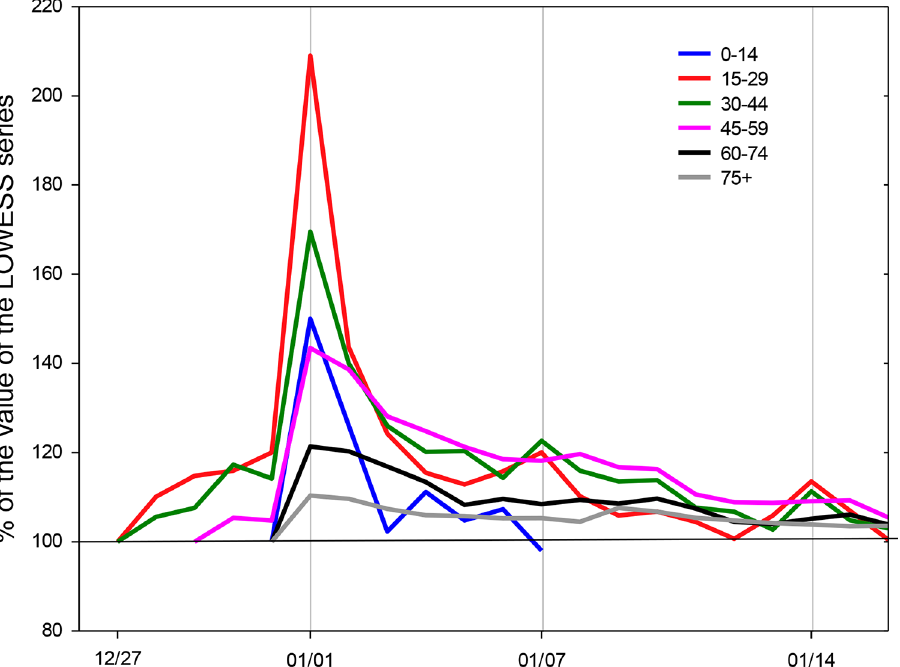
Fig. 7. Daily number of excess deaths in Russia from December 15 to February 1, sum of indicators for 2011–2019, % of the LOWESS moving average taken as 100%. Source: authors’ calculations based on modelling and Rosstat